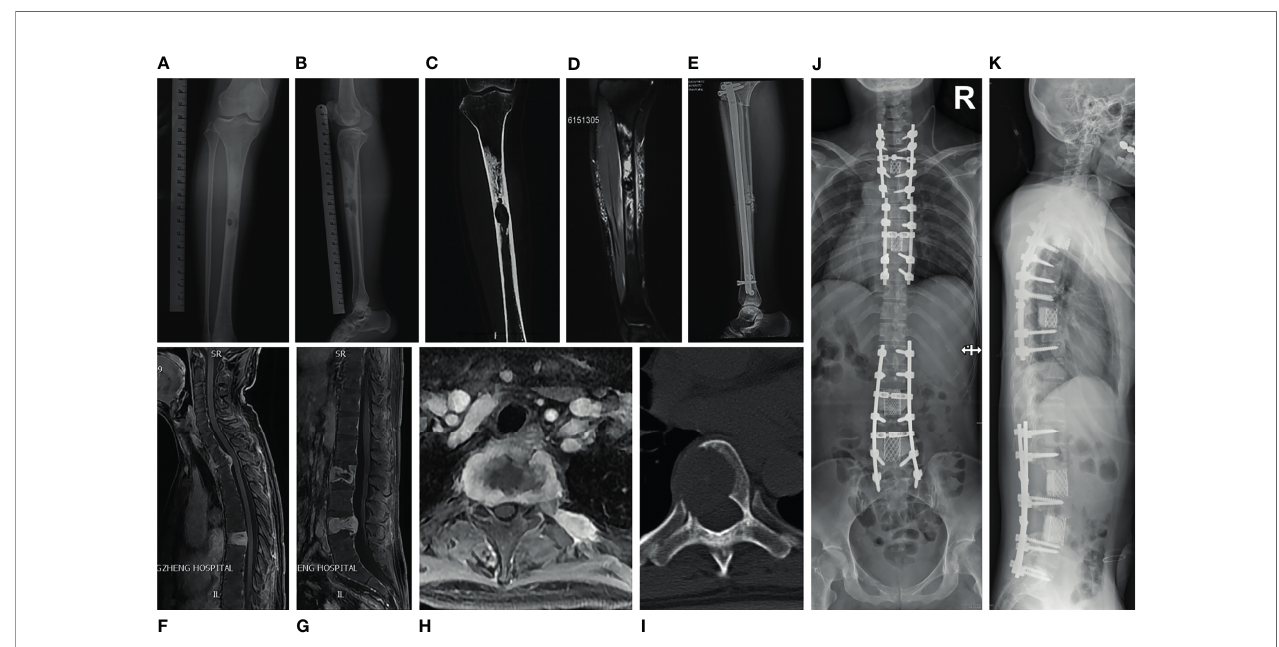
FIGURE 1 | Medical imaging of adamantinoma in case 1. (A, B) Anterior and lateral X-ray of the left tibia showed that there were two osteolytic well-circumscribed lesions in the tibial diaphysis, surrounded by a large area of sclerosis. The larger lesion was located in the medullary cavity, the smaller lesion was inside the cortex. (C) CT of the left tibia demonstrated an well-demarcated osteolytic lesion in the middle of the diaphysis with surrounding large areas of dense sclerotic bone. (D) MRI of the left tibia lesion revealed intense heterogeneous post-contrast enhancement with a central cystic non-enhancing area. (E) Lateral radiograph of the post-operative left tibia showed tibial osseous graft reconstruction with placement of an intramedullary rod and interlocking screws. (F – H) MRI of spine showed irregular osteolytic destruction in T2, T7, L2, L4 vertebral body and posterior elements, accompanied by the formation of paravertebral soft tissue masses, which demonstrated heterogeneous post- contrast enhancement. (I) CT of the thoracic spine showed a round osteolytic destruction with a clear demarcation, which extend into the spinal canal and cause spinal cord compression. (J, K) Postoperative X-ray of the spine showed the patient underwent spondylectomy and reconstruction for three times to resect multiple segments